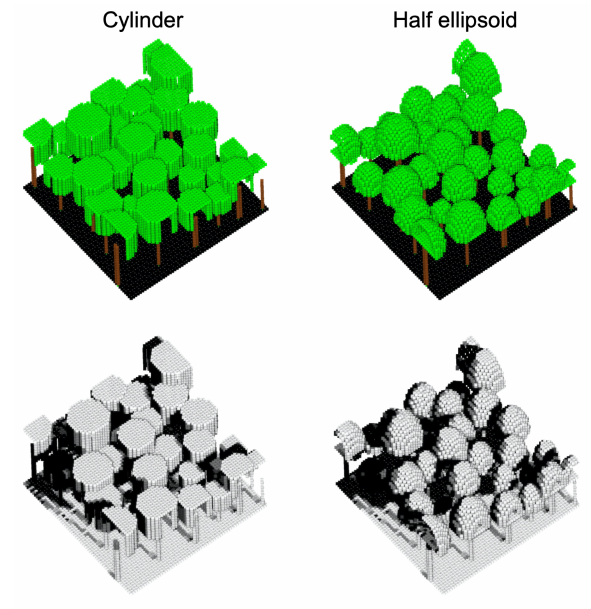
Figure 5. An example of a virtual forest using a cylinder and a half-ellipsoid as crown shapes. The height and position of the trees are the same in both forests, but the shadow ratio differs due to the difference in crown shape.